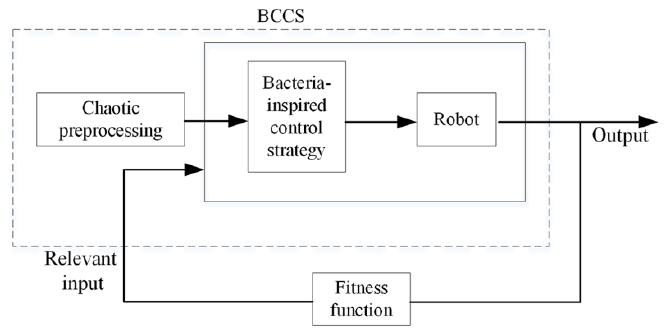
Figure 5. Feedback system architecture for robot motion based bacterial chemotaxis-inspired coordination strategy (BCCS).